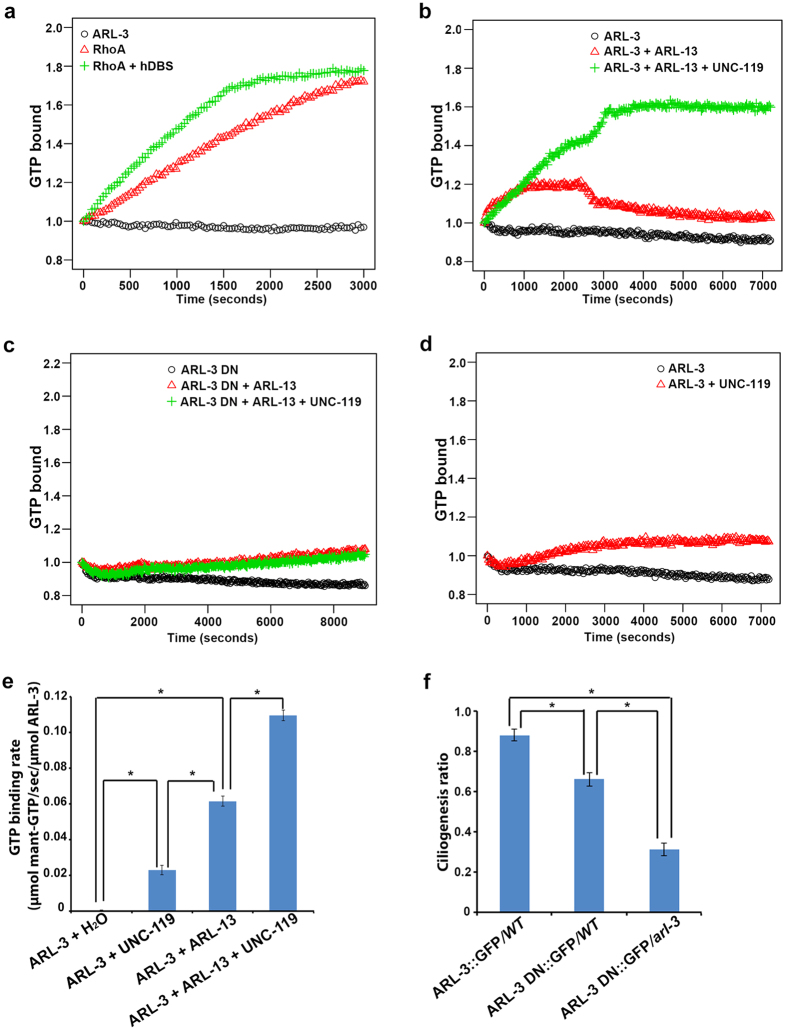
UNC-119 stabilizes the GTP binding of ARL-3.(a) Compare to RhoA, ARL-3 shows little intrinsic GTP binding. (b) ARL-13 alone can promote the GTP binding of ARL-3, but this binding is not stable. UNC-119 is needed for stabilizing the binding between ARL-3 and GTP. (c) Neither ARL-13 or ARL-13 + UNC119 can promote GTP binding of ARL-3 DN, suggesting that ARL-3, but not ARL-13, is responsible for GTP-binding activity. (d) Without ARL-13 functioning as a GEF, UNC-119 alone can promote GTP binding at a much slower rate. (e) GTP binding rates were calculated (see methods). (f) Ciliogenesis analyses show that excessive amount of ARL-3 DN lead to ciliogenesis defect, with more severe phenotype observed in arl-3 mutants than in Wt background. At least 40 animals (>160 cilia) were scored per genotype. All GTP binding assay were normalized with the initial fluorescence reading. All experiments were repeated at least three times, and representative graphs were shown here. *p < 0.001.